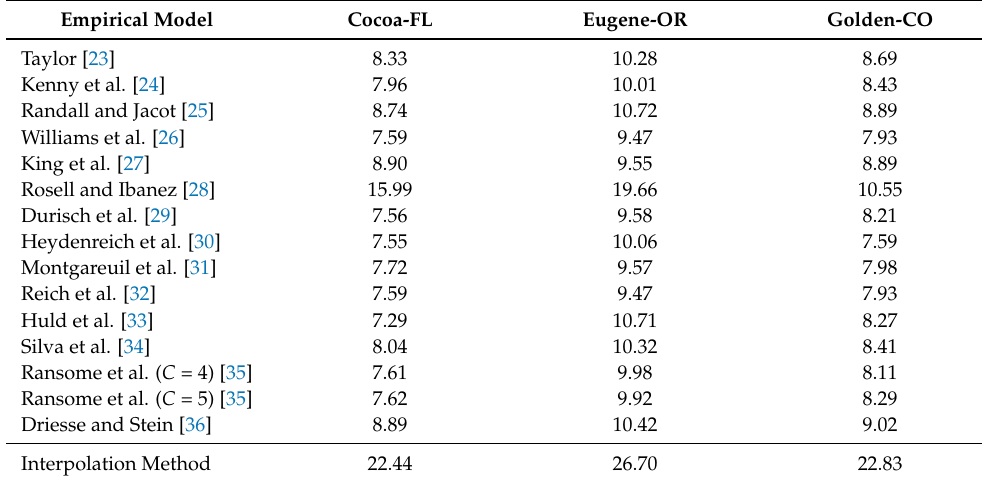
Table 5. RMSE values (%) calculated from the results obtained by each empirical model for each installation location of the PV modules under study when they were applied considering the proposed approach, and by the interpolation method that was recommended by IEC